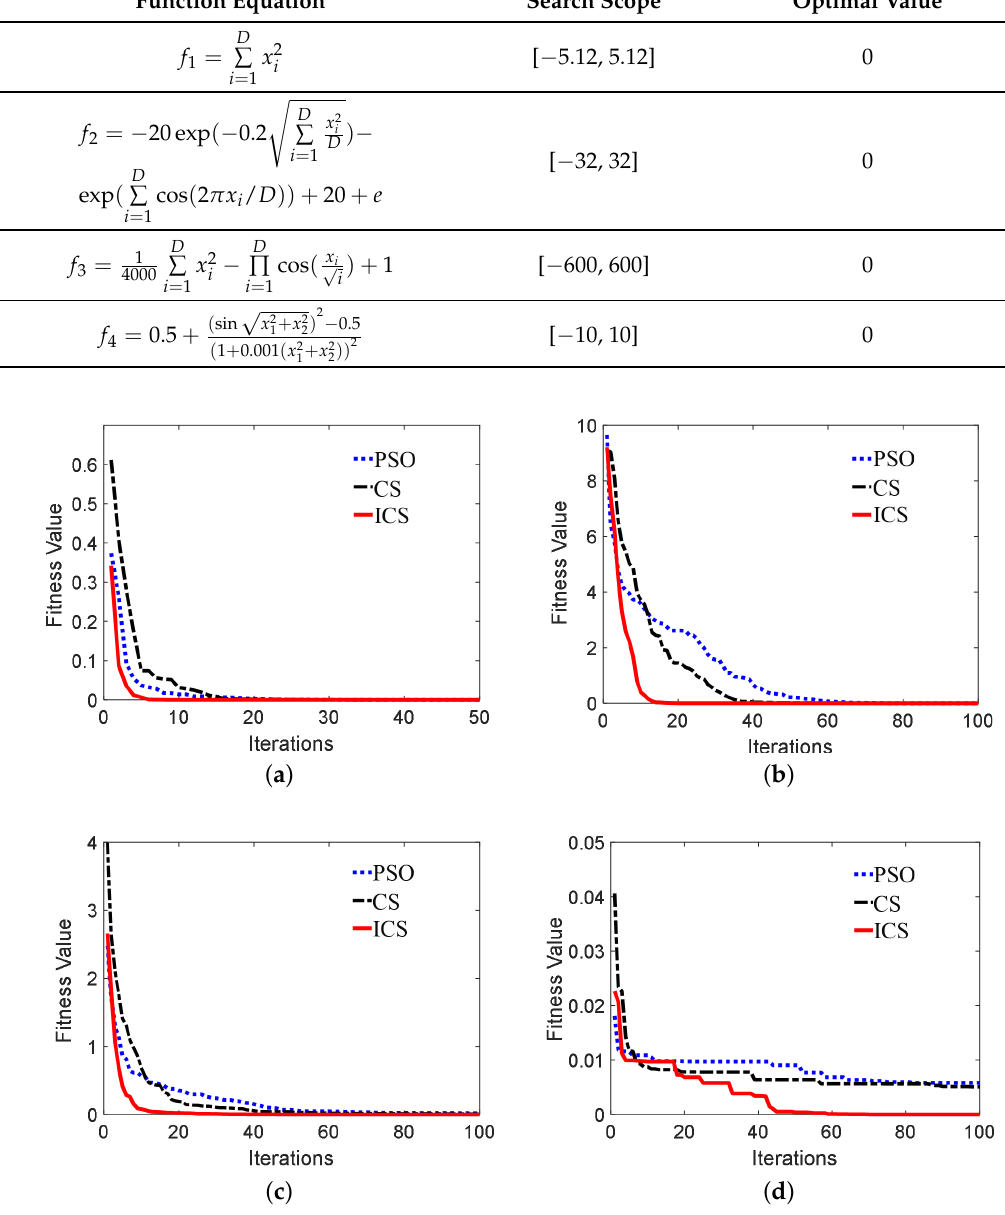
Figure 8. Fitness curves of test functions. ( a ) Sphere function; ( b ) Ackle function; ( c ) Girewank function; ( d ) Schaffer